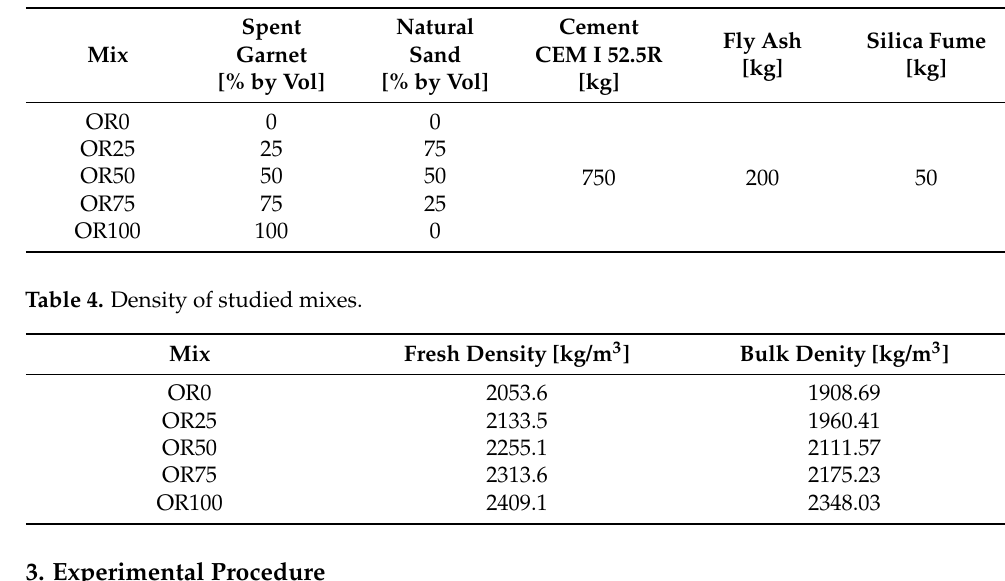
Figure 5. Design of the print path. 3.2. Test Setup and Uniaxial Compression Test Uniaxial unconfined compressive tests were conducted on the cylindrical specimens (D = 60 mm, H = 120 mm, Figure 6). Tests allowed for the determination of the green strength and stiffness of cement mortar. Similar approaches on green strength develop ‐ ment were used by other authors [14,21–23]. The tests were performed using a hydraulic press. A loading rate of 15 mm/min was assumed for the test. In order to precisely control the results, an additional precision force sensor with a range of up to 500 N (HBM C9C 0.5 kN) coupled to a HBM MGC Plus AB22A bridge was used. Deformations during testing were recorded using the GOM ARAMIS system, which controlled the displacements of nine markers placed on the specimen (Figure 7). In addition, the HBM MGC Plus AB22A strain gauge bridge provided a real ‐ time force signal to the ARAMIS system via an analog